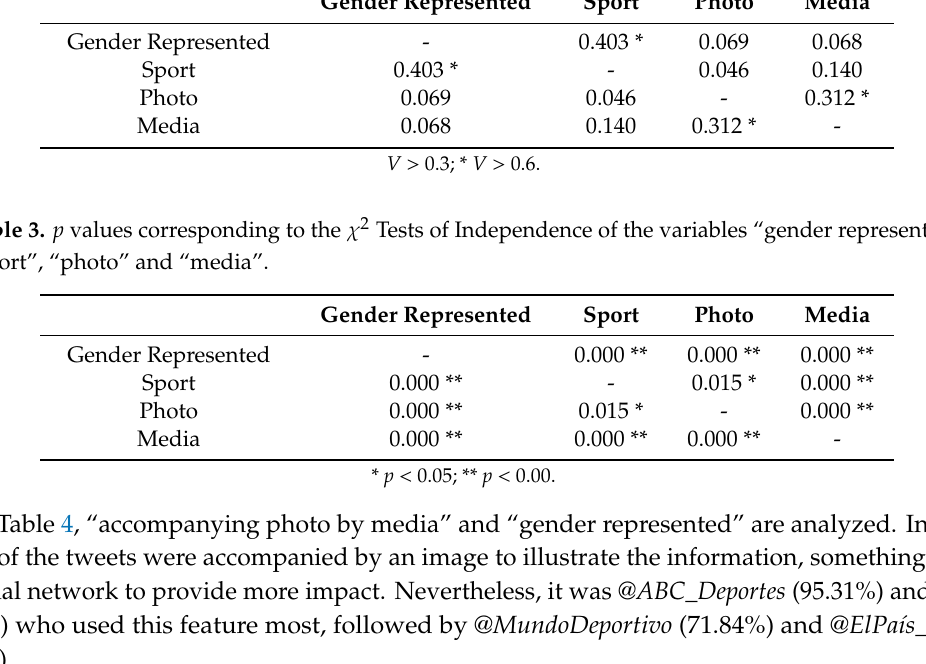
Table 2. Cramer’s coe ffi cient (V) of the variables “gender represented”, “sport”, “photo” and “media”. Gender Represented Sport Photo Media Gender Represented - 0.403 * 0.069 0.068 Sport 0.403 * - 0.046 0.140 Photo 0.069 0.046 - 0.312 * Media 0.068 0.140 0.312 * -